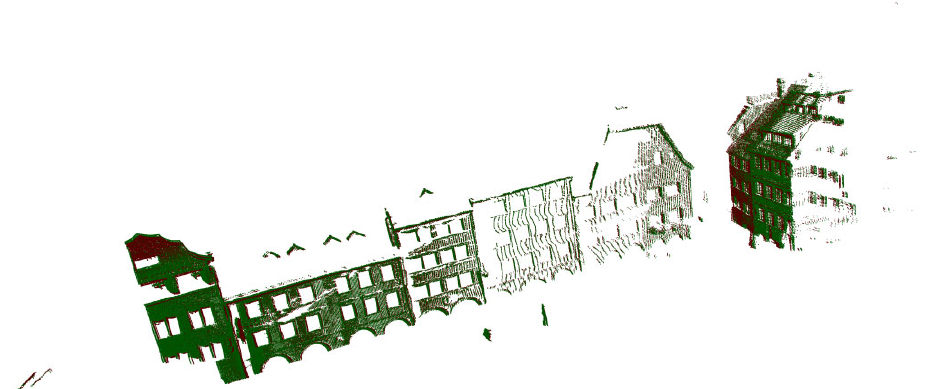
Figure 13. Optimal registration effect of some outdoor point clouds.